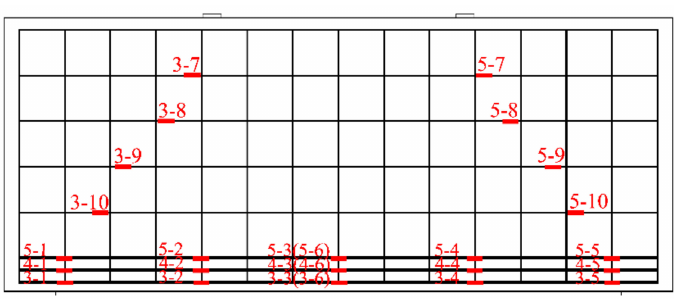
Figure 7. Arrangement of strain gauge of reinforcements.